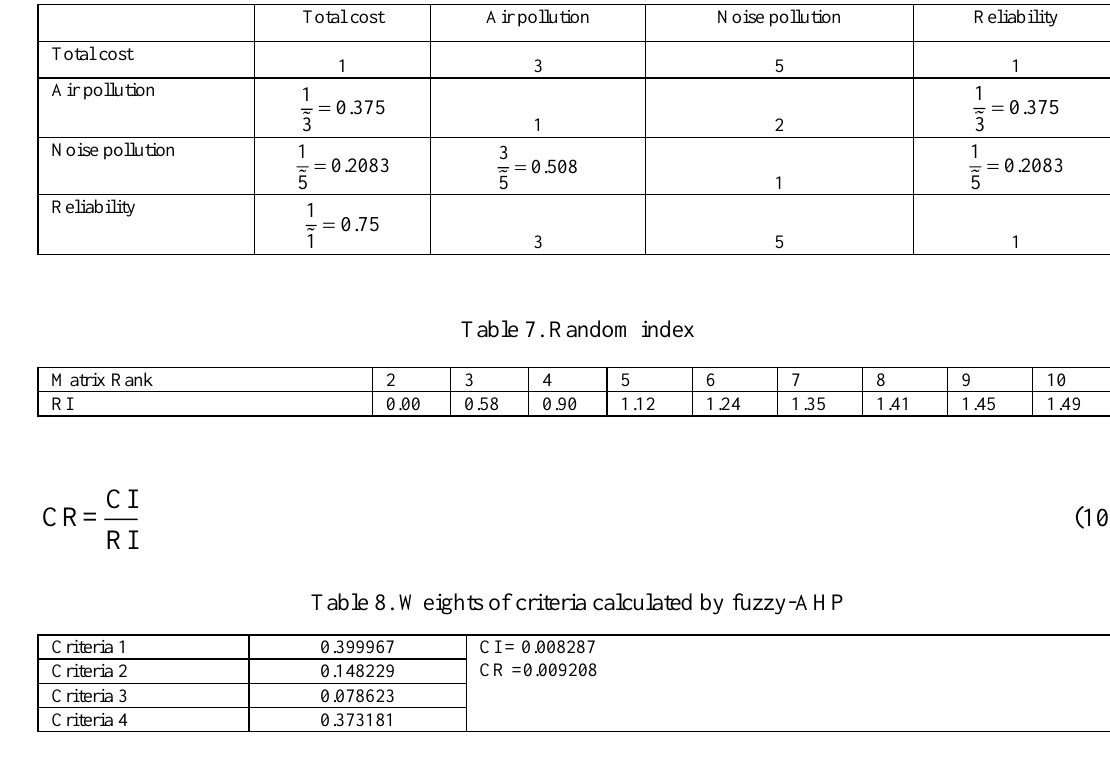
Table 6. Fuzzy AHP comparison matrix